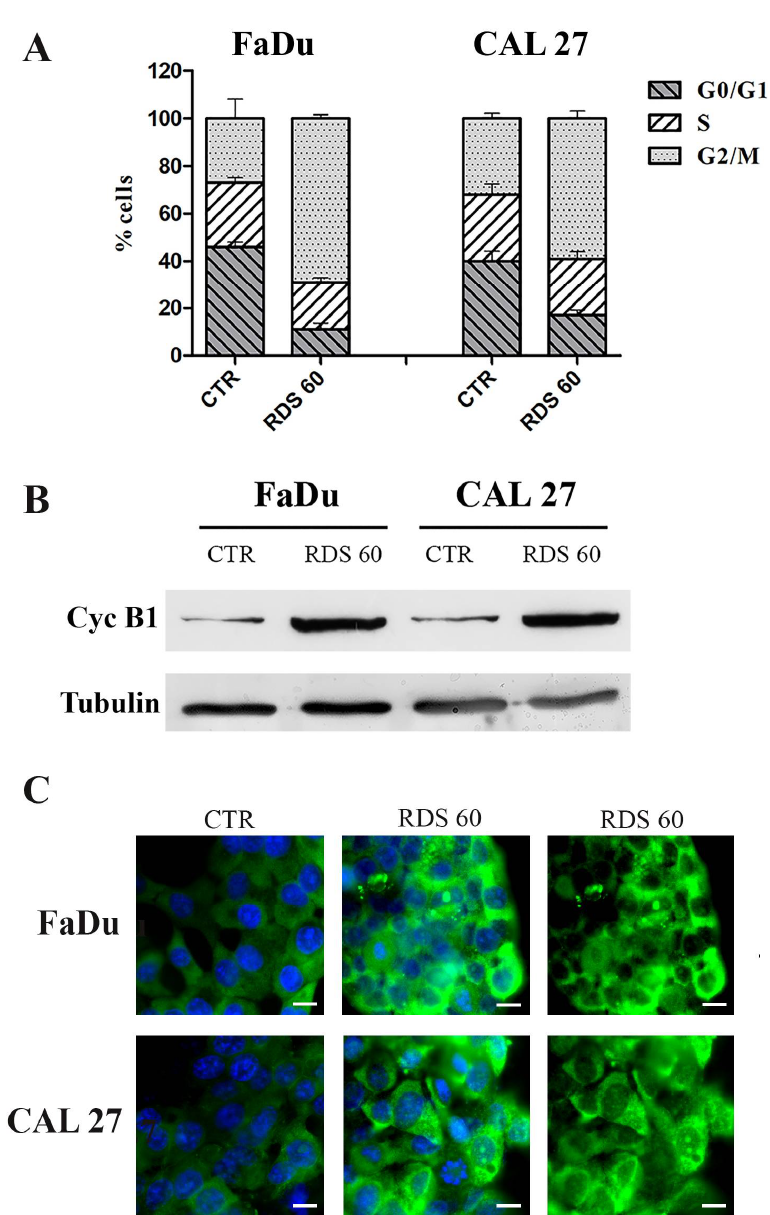
Figure 3. Block in G2/M and up-regulation of cytoplasmic cyclin B1 in HNSCC cell lines induced by RDS 60. ( A ) Cell cycle evaluated by flow cytometry of FaDu and CAL27 untreated (CTR) and 1 μM RDS 60 treated for 24 h. The histogram shows the media ± SD representative of results obtained from three independent experiments. ( B ) Western blot of cyclin B1 from FaDu and CAL27 untreated (CTR) and 1 μM RDS 60 treated for 24 h. ( C ) Immunofluorescence staining of cyclin B1 on FaDu and CAL27 untreated (CTR) and 1 μM RDS 60 treated for 24 h shown with and without nuclear staining; bar 7 μm.